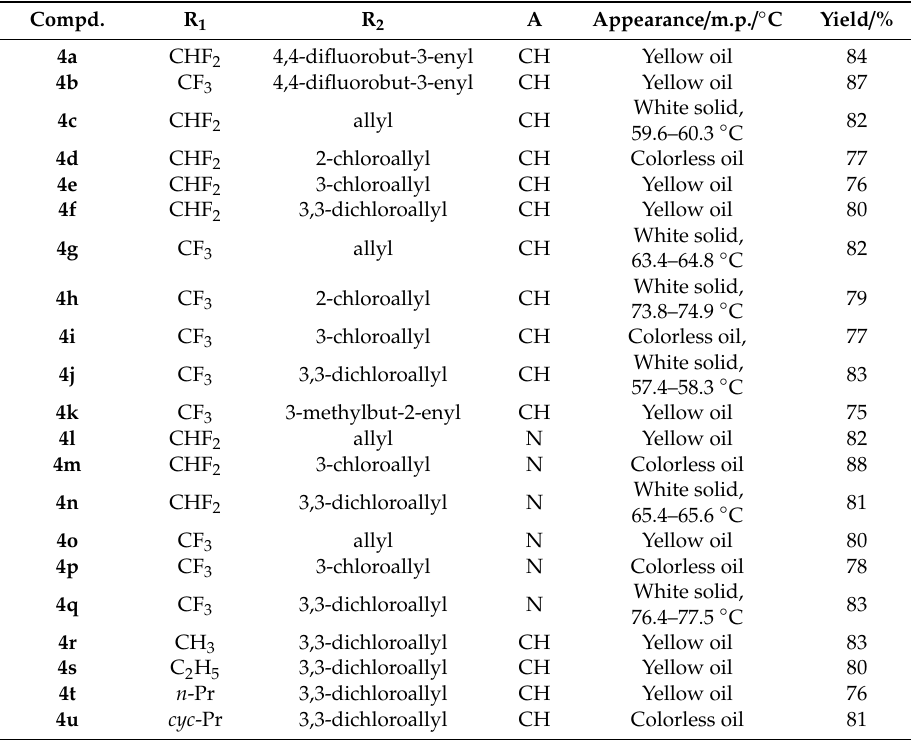
Table 2. The physical properties of the compounds 4a – 4u.